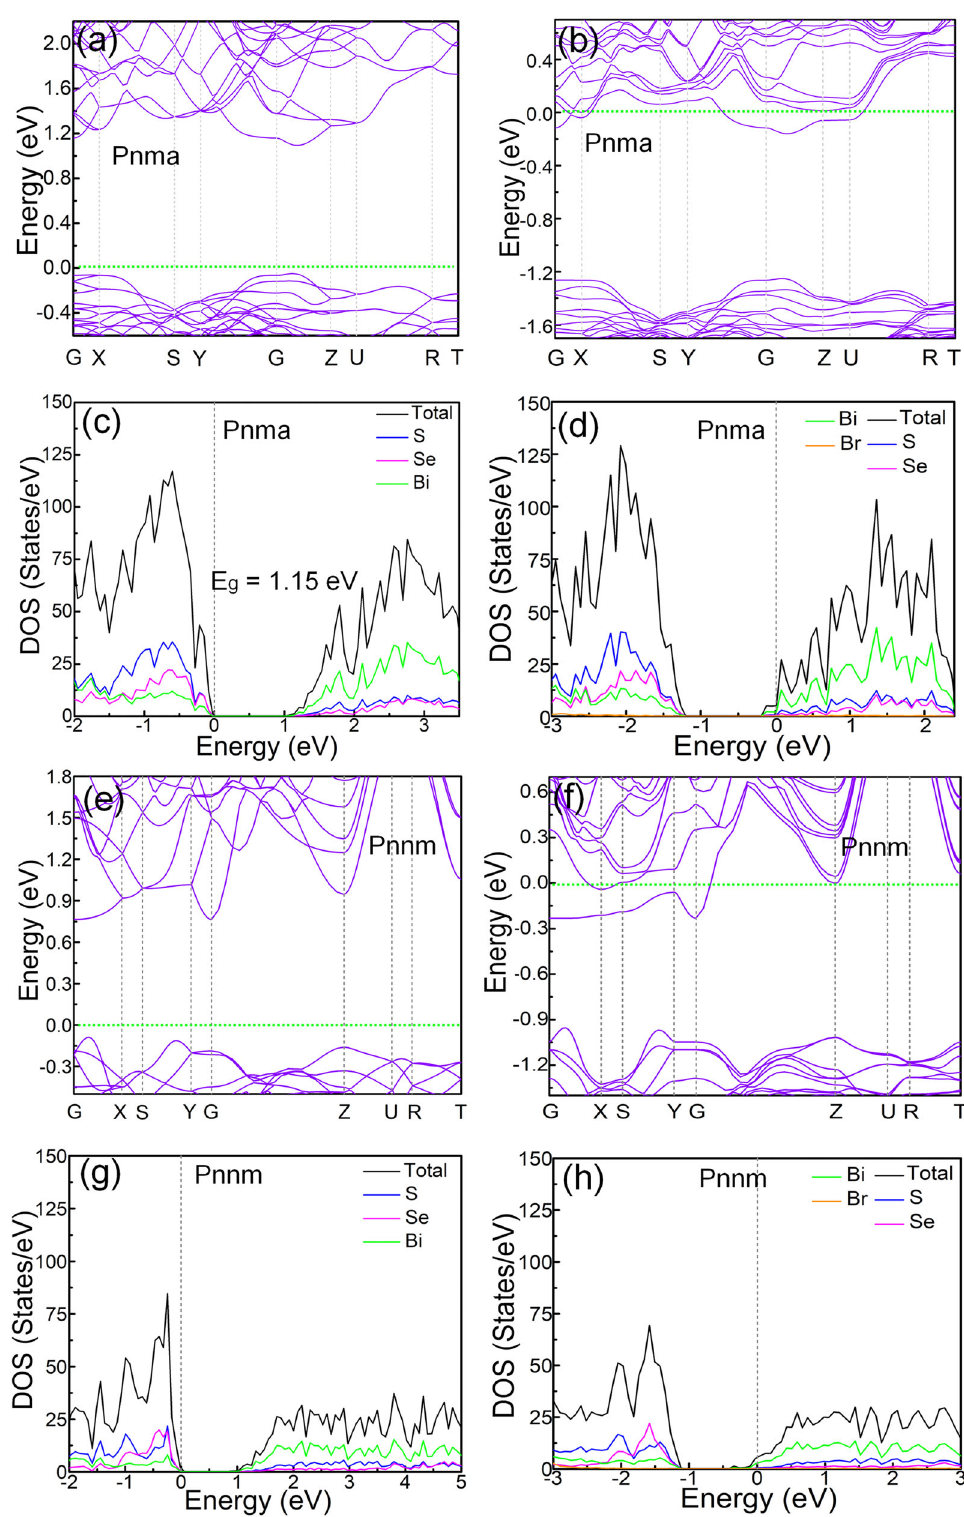
Fig. 6 Electronic band structure and density of state (DOS) calculations. a and c Electronic band structure and DOS of pure Bi 2 SeS 2 with Pnma structure. b and d Electronic band structure and DOS of Br-doped Bi 2 SeS 2 with Pnma structure. e and g Electronic band structure and DOS of pure Bi 2 SeS 2 with Pnnm structure. f and h Electronic band structure and DOS of Br-doped Bi 2 SeS 2 with Pnnm